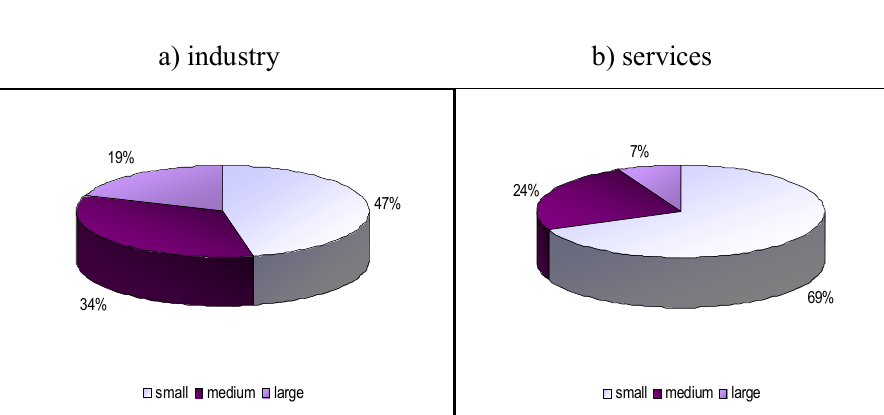
Figure 3 - Percentage share of small, medium and large innovation active enterprises in the total number of innovative enterprises in industry and services